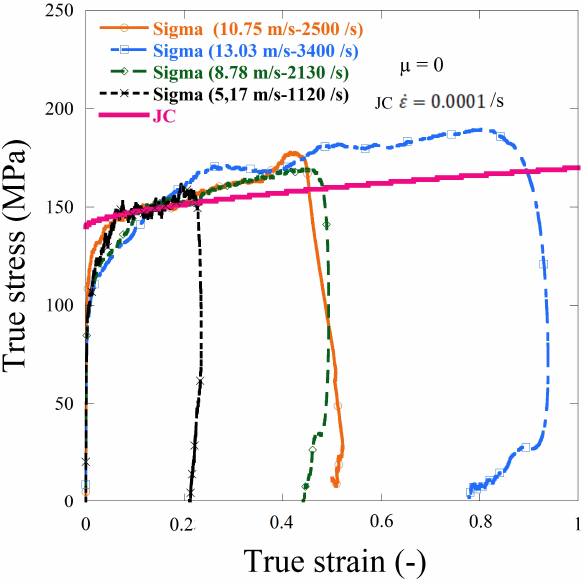
Figure 13. Experimental dynamic compression results using the split Hopkinson pressure bar (HSPB) system, curves without friction correction.